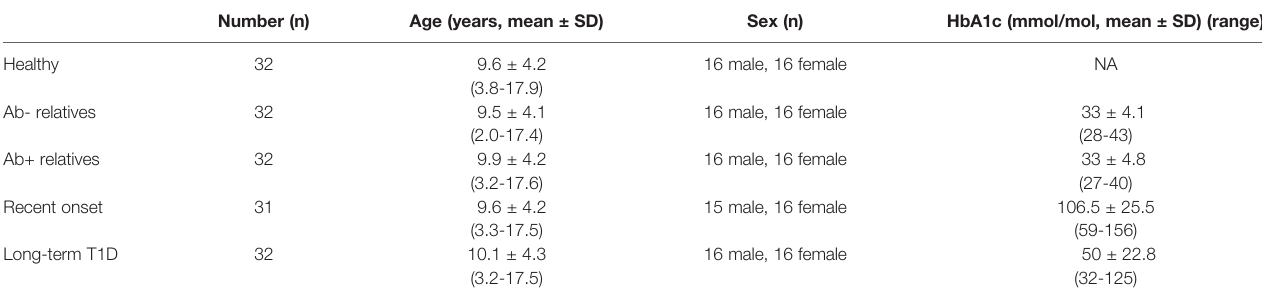
TABLE 2 | Cohort description – serum neutrophil